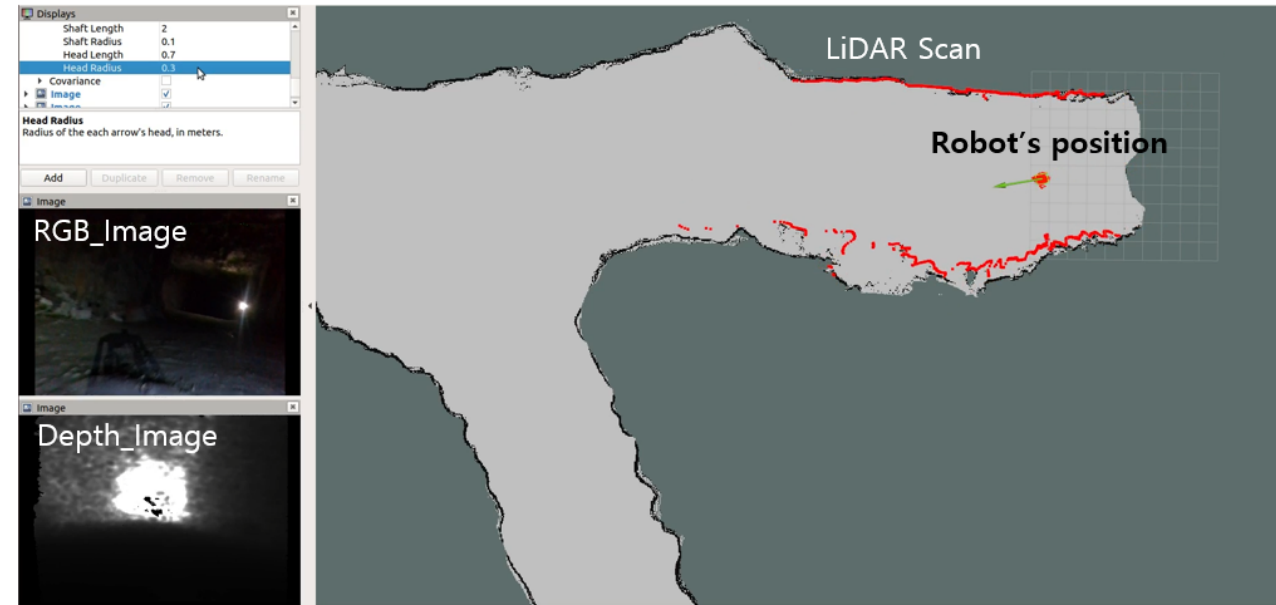
Figure 5. User interface of the autonomous driving robot system in ROS.